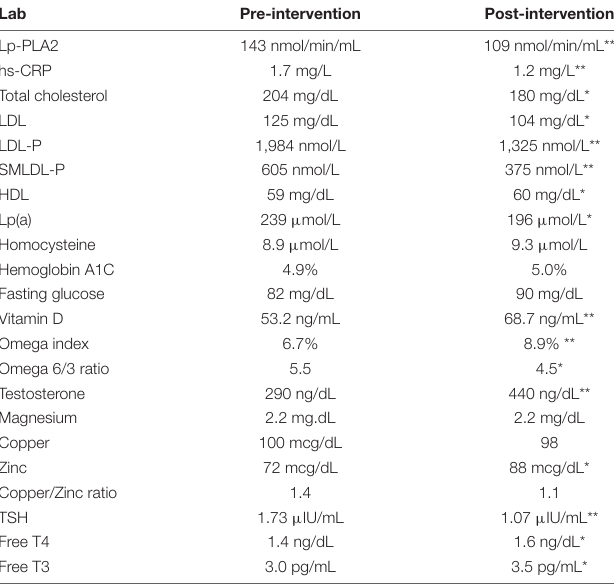
TABLE 2 | Comparison of pre- vs. post-intervention serum laboratory values for Mr. A.